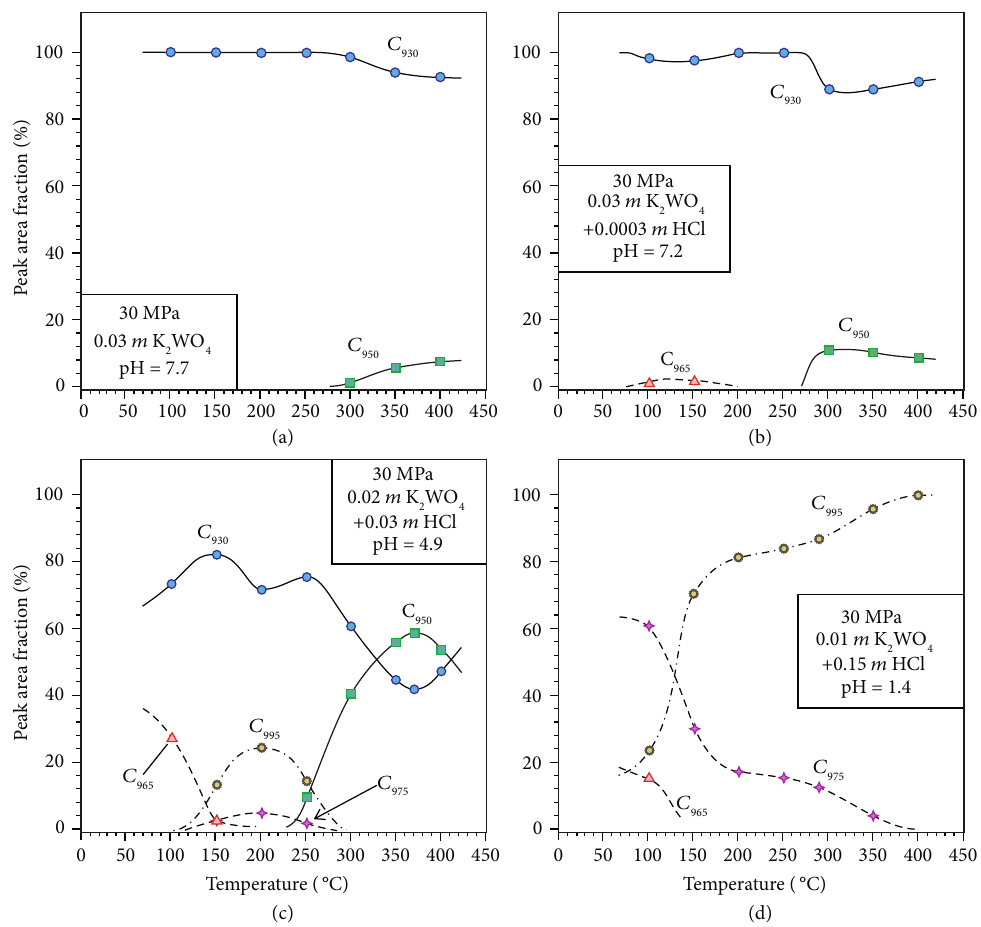
Figure 3: Peak area fractions of di ff erent v 1 (W=O) bands as a function of temperature and at constant pressure of 30MPa. (a) 0.03 m K 2 WO 4 ; (b) 0.03 m K WO +0.0003 m HCl; (c) 0.02 m K WO +0.03 m HCl; and (d) 0.01 m K 2 4 2 4 fi gure are used to show the general variation trend of the peak area fractions. Data plotted are those listed in Table